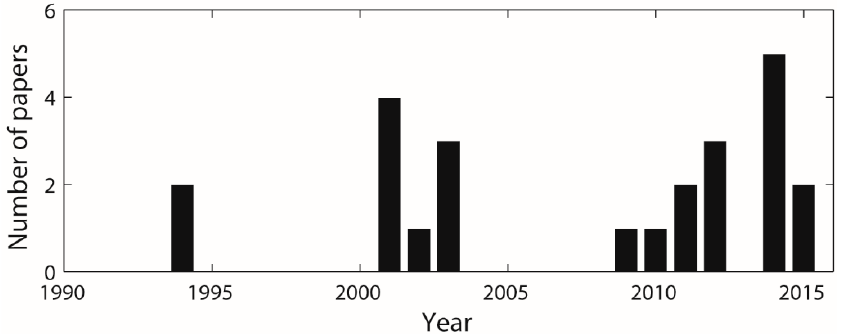
Figure 3. Number of papers published in each year from 1990–2015 on assimilating remotely sensed soil moisture data into flood forecasting models (calculated based on Table 4).